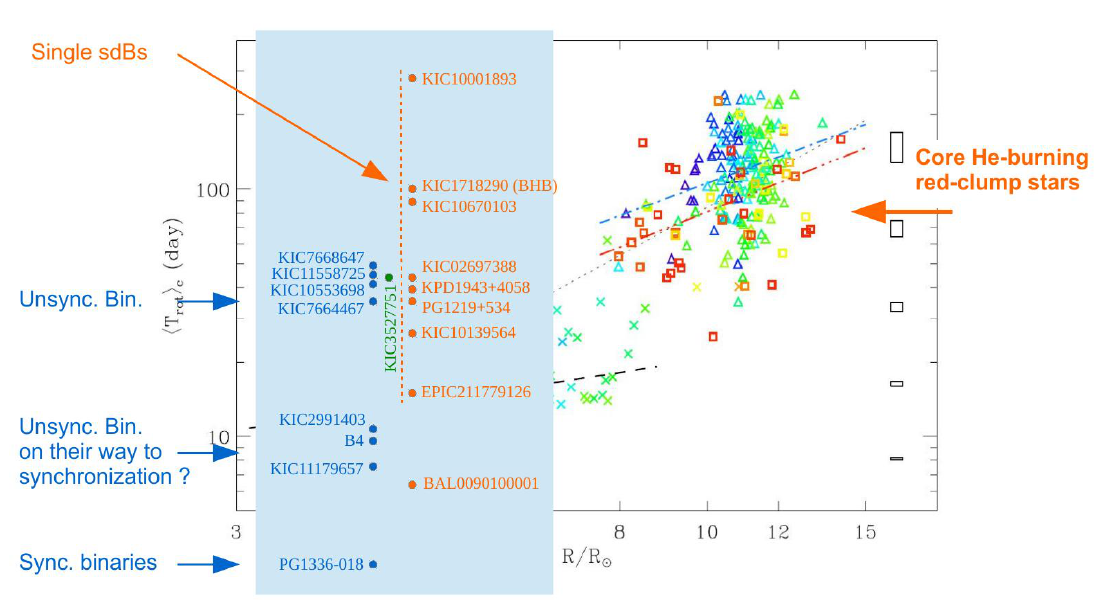
Figure 3. Comparison of the rotation periods derived for the sdB stars listed in Table 1 and Table 2 (left side of the figure) with the rotation periods measured for the cores of red-clump stars (from Figure 9 of Mosser et al. 2012). See text and Mosser et al. (2012) for further